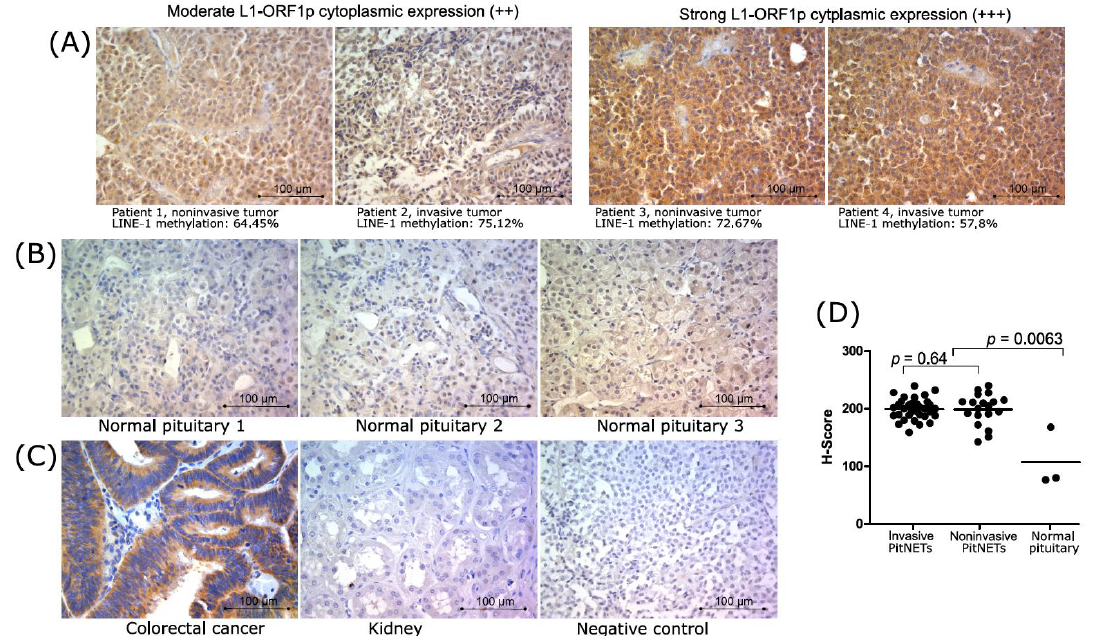
Figure 3. L1-ORF1p expression in nonfunctioning gonadotroph PitNETs. ( A ) Representative immunostaining showing expression of L1-ORF1p in tumor samples, magnification ×400. The results of LINE-1 DNA methylation assessment for each sample are provided below the tissue image; ( B ) Immunoreactivity against L1-ORF1p in normal pituitary sections, magnification ×400. ( C ) Results of immunostaining in colorectal cancer and normal kidney samples used as positive and negative controls, respectively, as well as technical negative control (procedure without primary antibody), magnifi-cation ×400; ( D ) The results of quantification of immunoreactivity in normal pituitary and tumor samples stratified according to invasive growth status with H-score calculation.